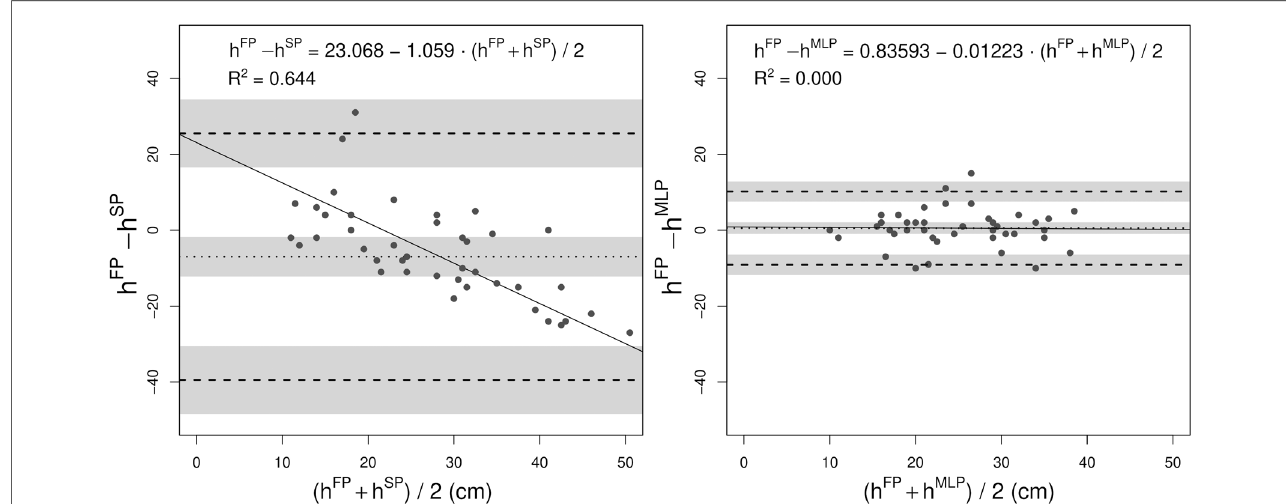
FIGURE 5 Bland-Altman analysis for the height estimates obtained directly from the SP with the TOV method (left) and through the MLP (right). The continuous line represents the bias (b) computed as the average difference between the gold standard and the estimate; the dot-dashed lines represent the lower and upper con fi dence intervals (UB and LB, respectively), computed as 1.96 standard deviations of the difference distribution away from the bias, in both directions. The gray shaded areas indicate the con fi dence interval for b, UB, and LB, respectively. The continuous line is the regression line of the average versus the differences, which equation is indicated in the above portion of the graph. The R 2 value refers to the latter